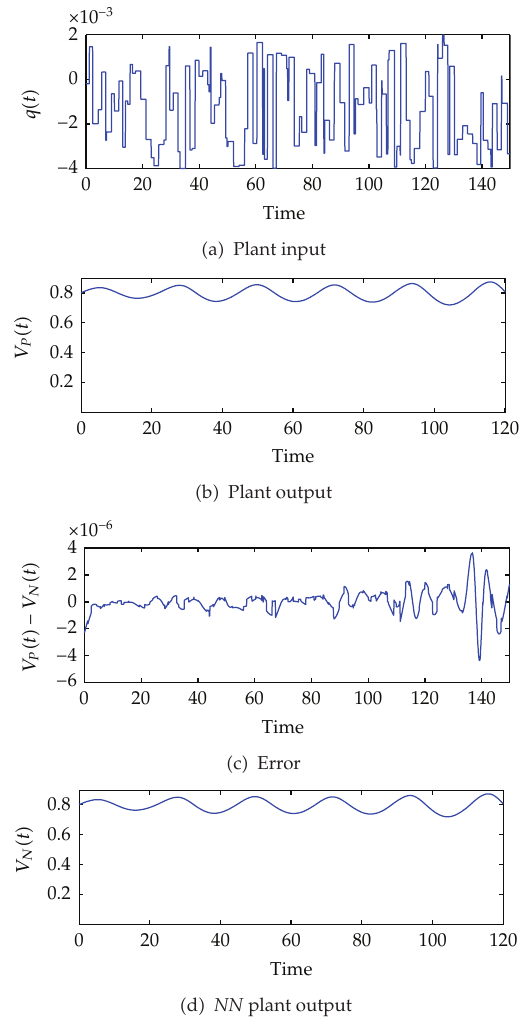
Figure 5: Training data for NN MRC of GGC